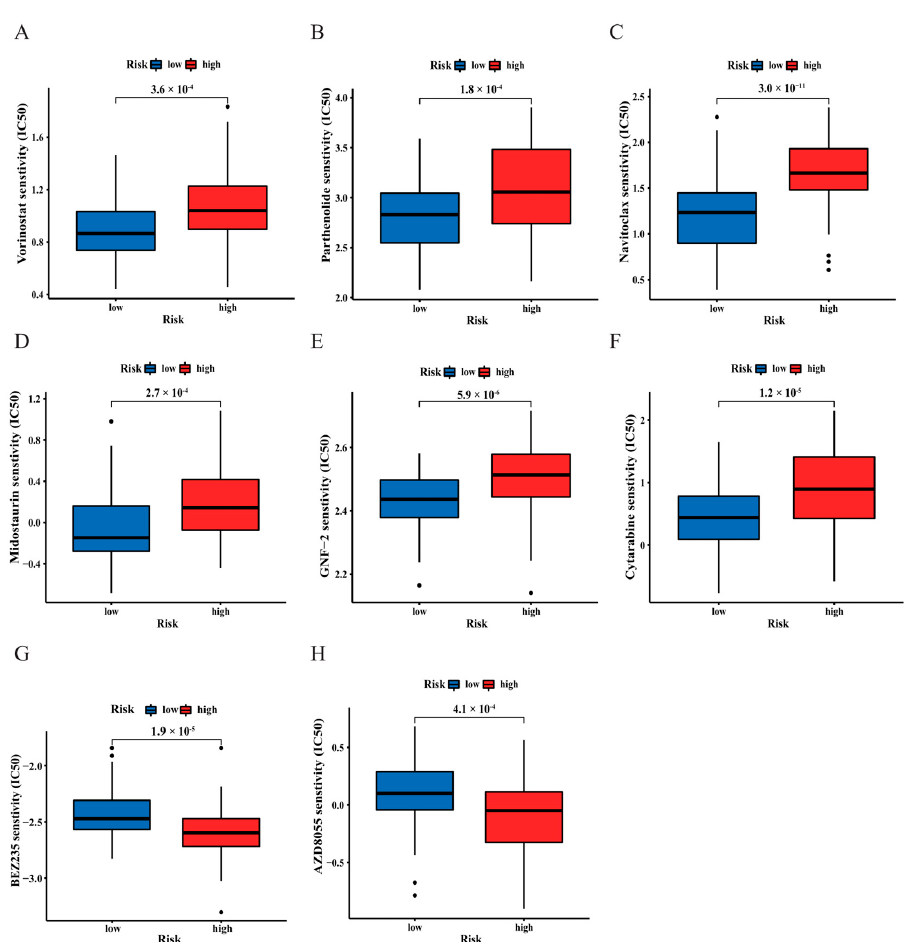
Figure 9. Drug sensitivity predictions in different risk groups. ( A – H ) Vorinostat, parthenolide, navitoclax, midostaurin, GNF-2, cytarabine (Ara-C), BEZ235, and AZD8055 .